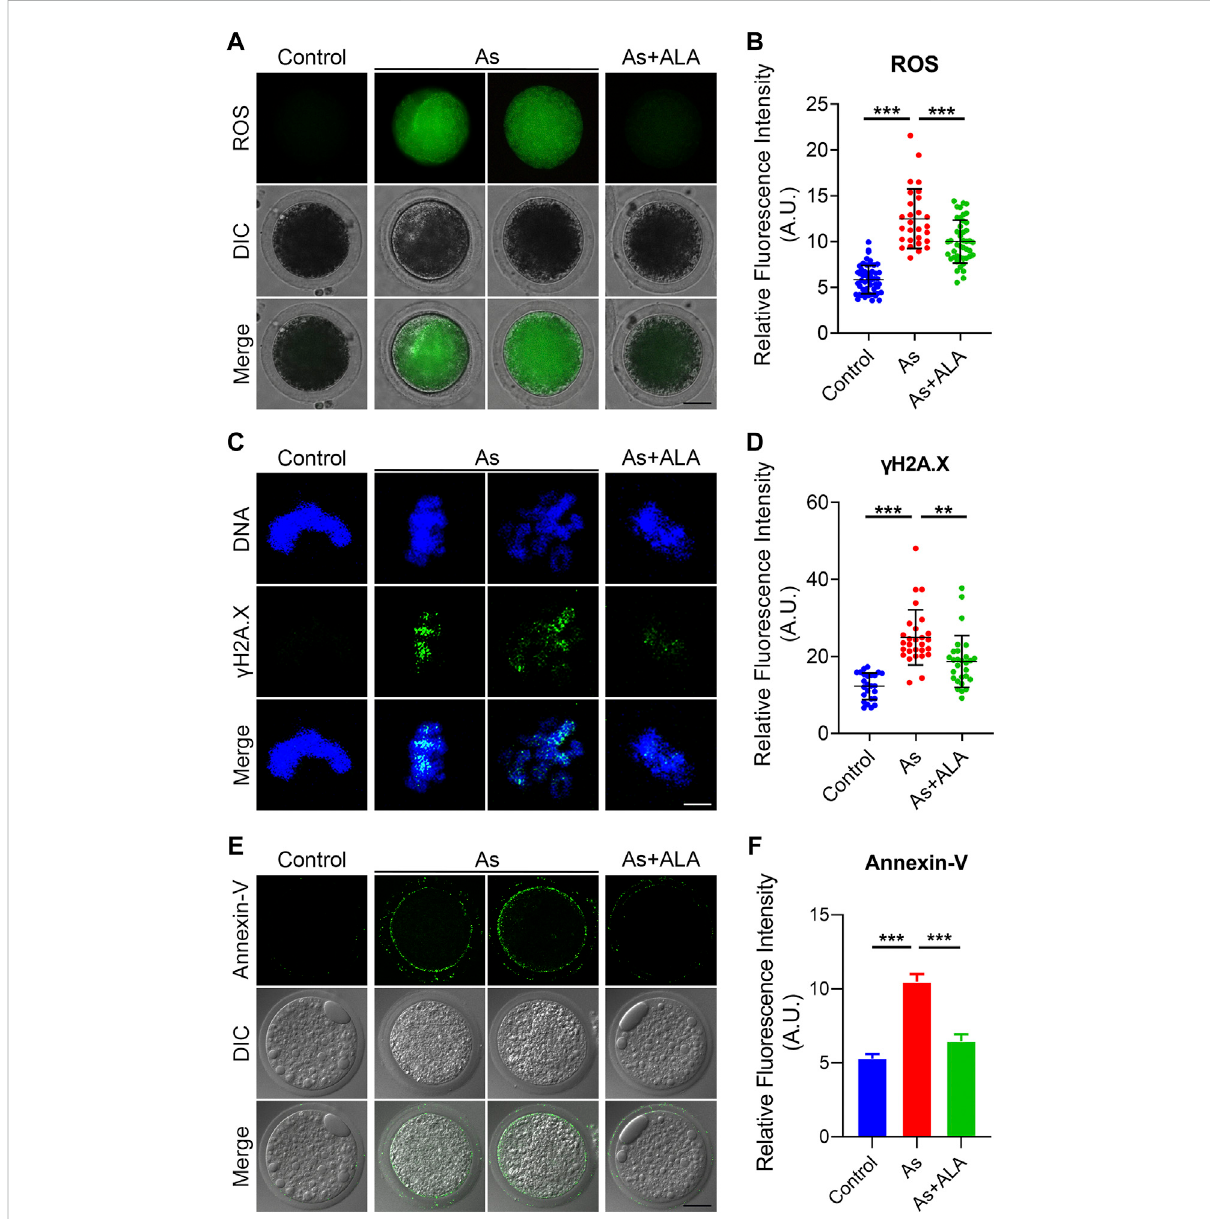
FIGURE 6 EffectofALAsupplementationonROSlevels,DNAdamageandapoptosisinarsenite-exposedoocytes. (A) RepresentativeimagesofROSlevels in control, arsenite-exposed and ALA-supplemented groups. Scale bar, 30 µm (B) The fl uorescence intensity of ROS were measured in control, arsenite-exposed and ALA-supplemented groups. (C) Representative images of DNA damage in control, arsenite-exposed and ALA-supplemented groups. Oocytes wereimmunostained with annexin-V-FITC.Scale bar, 2.5 µm. (D) The fl uorescence intensity of γ H2AX signals weremeasured in control, arsenite-exposed and ALA-supplemented groups. (E) Representative images of apoptotic oocytes in control, arsenite-exposed and ALA- supplemented groups. Oocytes showing signals of fl uorescence (green) in their membrane are regarded as early-stage apoptosis. Scale bar, 30 µm. (F) The fl uorescence intensity of Annexin-V signals were measured in control, arsenite-exposed and ALA-supplemented groups. Data were presented as mean percentage (mean ± SEM) of three independent experiments. * p < 0.05, *** p <